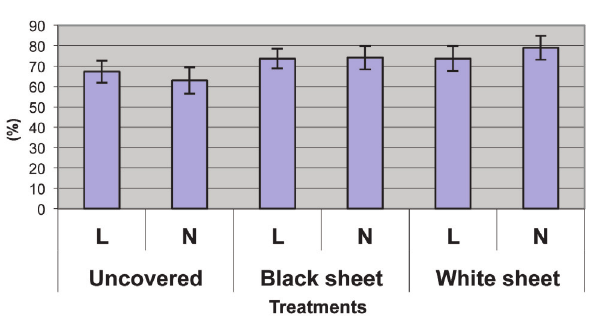
Figure 1. Leaf weight in the ratio of total biomass production (%) by the first cutting (L-low cutting, N-normal